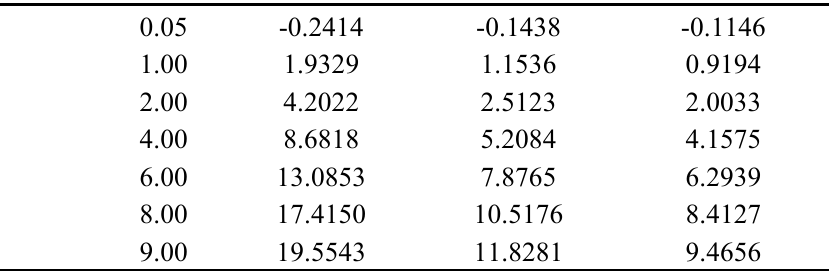
Table 3. Numbers used for plotting Figure 6 for plot of e.m.f. vs. surface area for electrode s2.